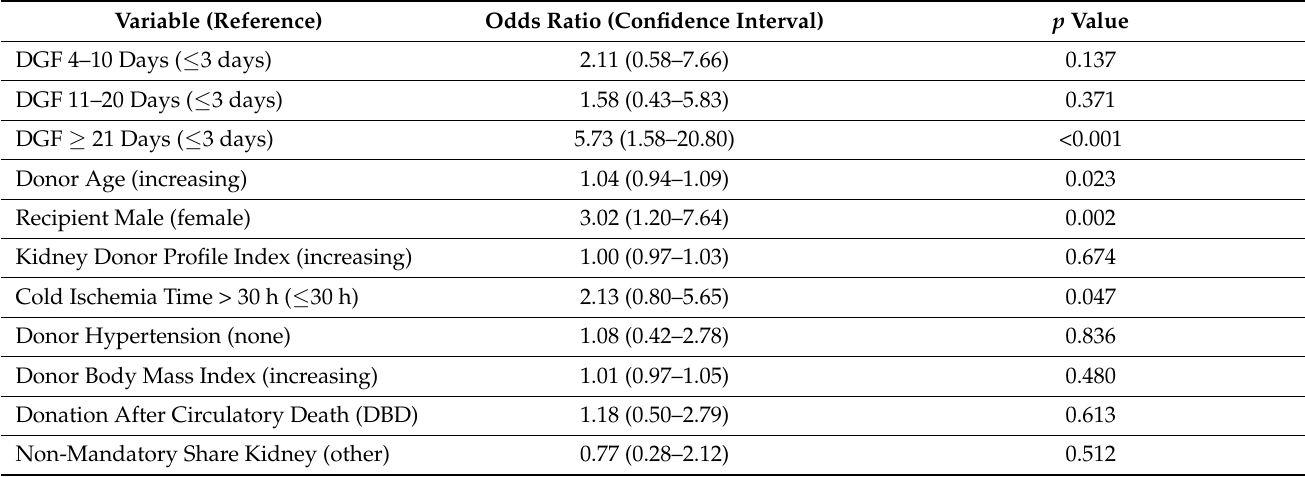
Table 3. Multivariate logistic regression model for 12-month eGFR <40 mL/min/1.73 m 2